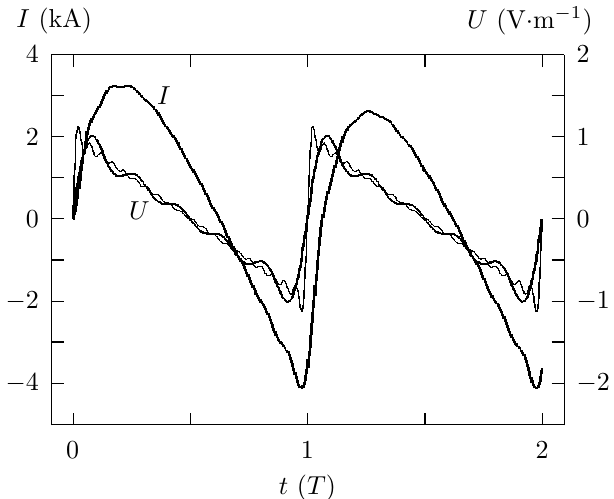
Figure 8. Example 4, d = 16 mm, f = 60 Hz, ˆ U = 1 V terms of the series (12) for n = 5 (solid line) and n = 20 (thin line). The current I in the conductor A 1 when approximating the voltage by ten terms of the series